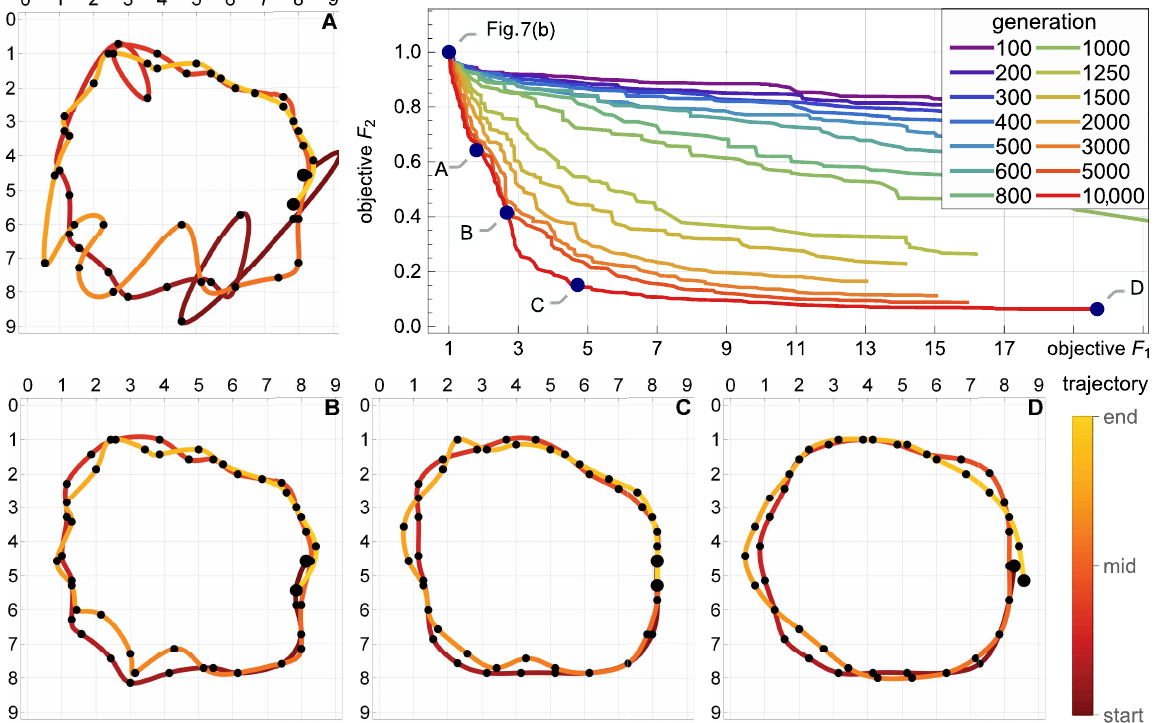
Figure 9. Multicriterial identification of the circle trajectory: advancement of the Pareto front and four specific trajectories along the final front (A, B, C and D). The top left dot on the Pareto front corresponds to the trivial F 1 -optimum trajectory shown in Figure 7b. The actual trajectory is shown in Figure